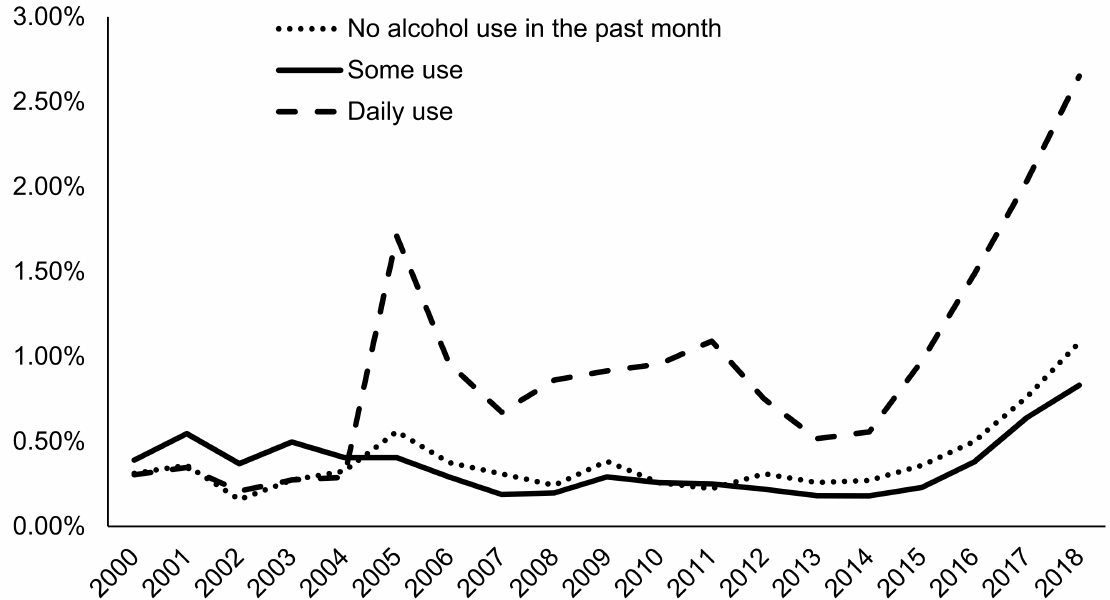
Figure 6. Prevalence of naltrexone treatment prescribed in alcohol use disorder (AUD) admissions from 2000–2018 by frequency of alcohol use at admission using TEDS-A data. Temporal trends were significant by the Cochran–Armitage trend test ( p <